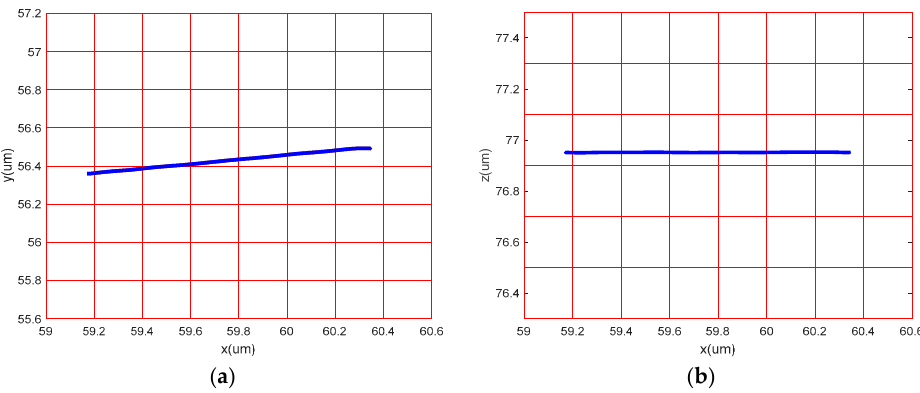
Figure 31. Linear motion performance test in x direction. ( a ) Projection on the xoy plane; ( b ) projection on the xoz plane.